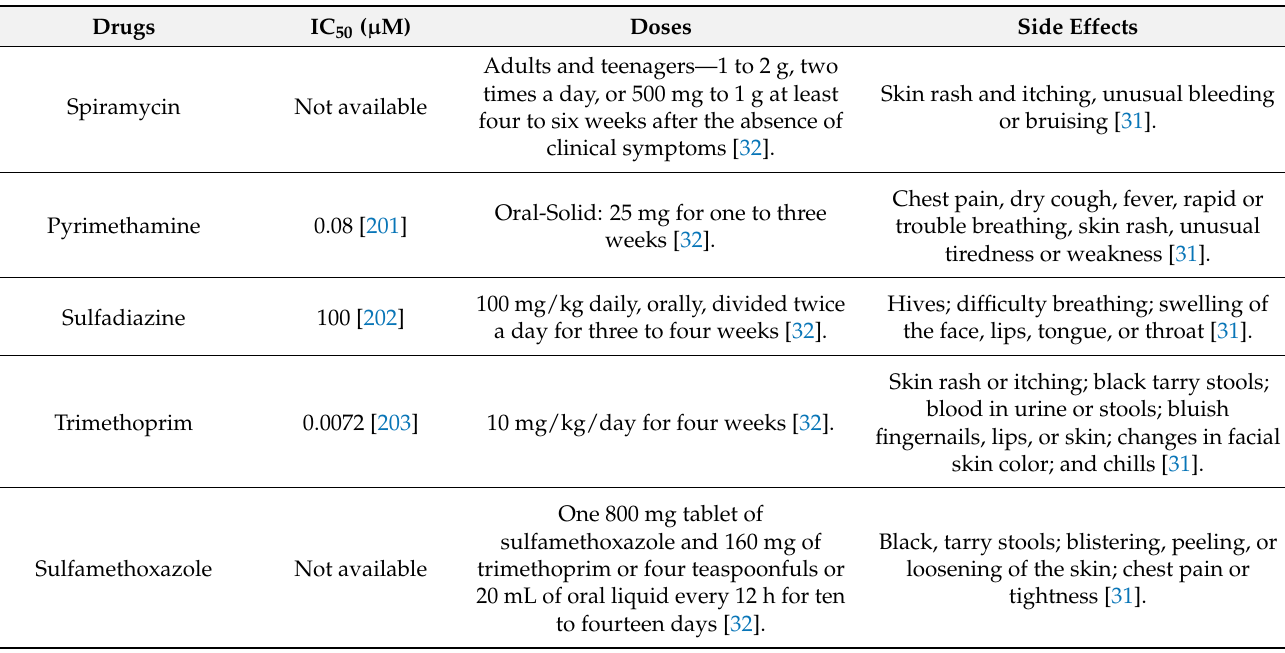
Figure 18. First-line drugs for the pharmacological treatment of toxoplasmosis. Table 6. Biological activity, dose, and adverse effects of drugs used against toxoplasmosis.